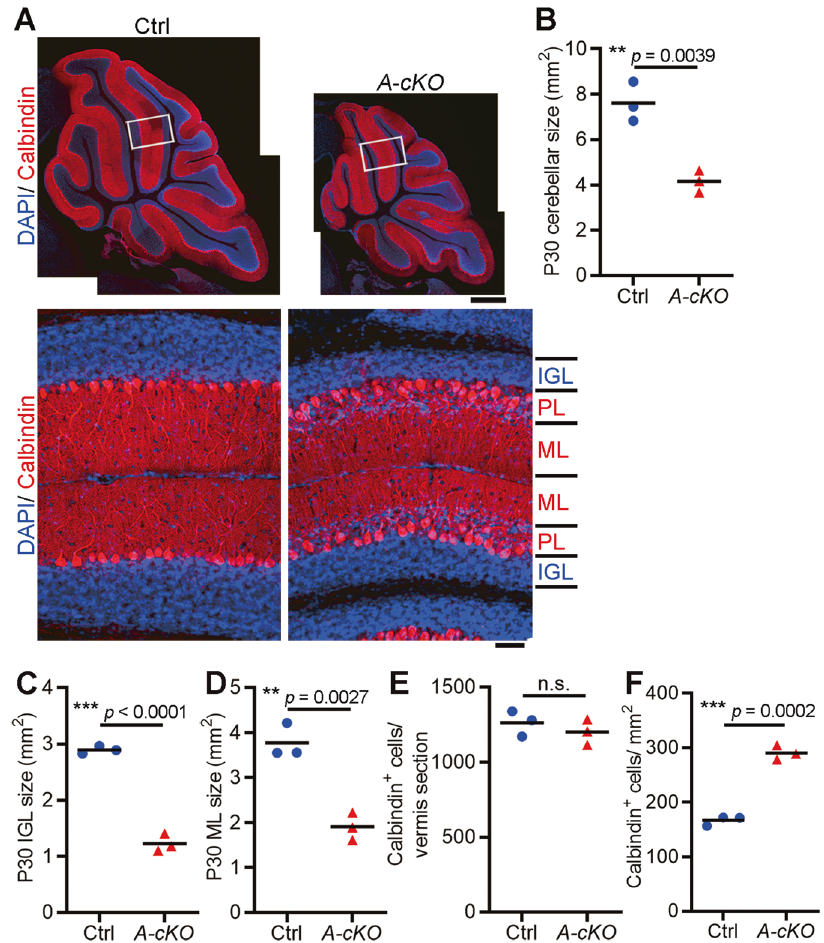
Fig. 4 Wdr4 de fi ciency in cerebellar GNPs leads to IGL and ML size reduction and Purkinje neuron disorganization. A – F Representative confocal images ( A ) and quantitative data ( B – F ) showing the sizes of cerebellum ( A , B ), IGL ( A , C ), ML ( A , D ), and the number ( A , E ) as well as the density ( A , F ) of Purkinje neurons, in the P30 Wdr4 A-cKO and control mice. The upper-left panel in ( A ) was stitched with several images to display the whole cerebellum. The lower panels in ( A ) are higher magni fi cation images of the boxed regions in the upper panels, showing disorganized Purkinje neurons in P30 Wdr4 A-cKO cerebella (scale bars, 500 μ m in the upper panels and 50 μ m in the lower panels). Data were from 3 cerebella in each group and analyzed using two-tailed unpaired Student ’ s t -test without Welch ’ s correction (equal variances), p = 0.0039 in ( B ), < 0.0001 in ( C ), 0.0027 in ( D ), 0.4276 in ( E ), and 0.0002 in ( F ). Data are represented as individual points and mean; ** p < 0.005, *** p < 0.0005; n.s., non-signi fi